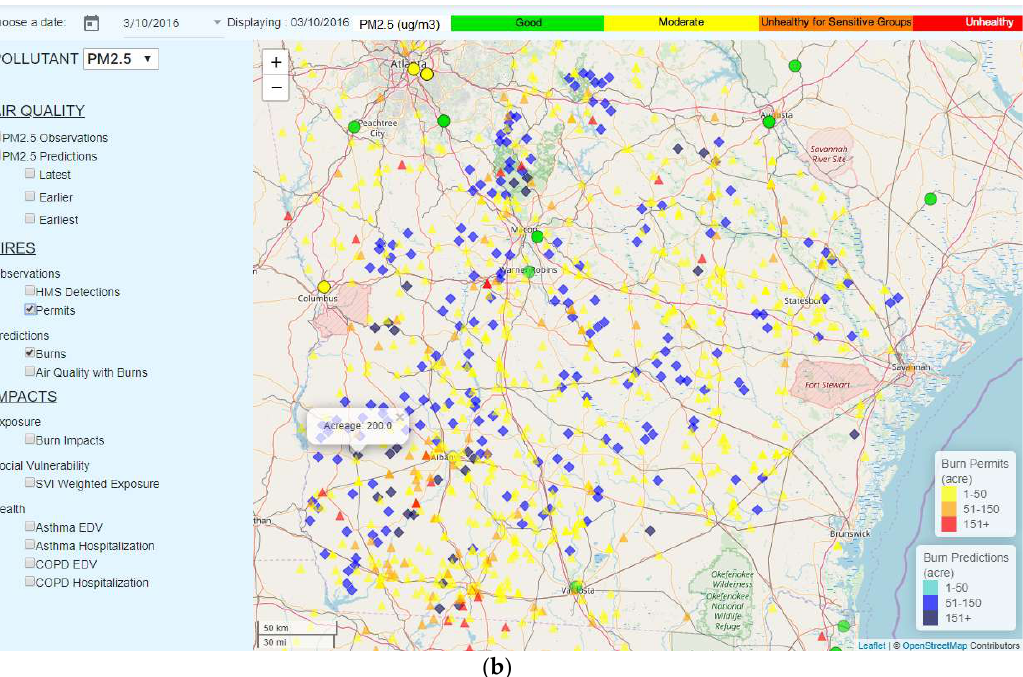
Figure A5. The SIPFIS webpage displays ( a ) HMS detections (burgundy diamonds) and ( b ) permits (yellow, orange, and red triangles), with acreage information. 11. Check the box for “SVI‐weighted exposure” under “Impacts” on “Social Vulnerability”, on the left‐hand‐side menu, to show spatial distribution of the SVI‐weighted exposures to smoke causing increased PM 2.5 levels (Figure A6).